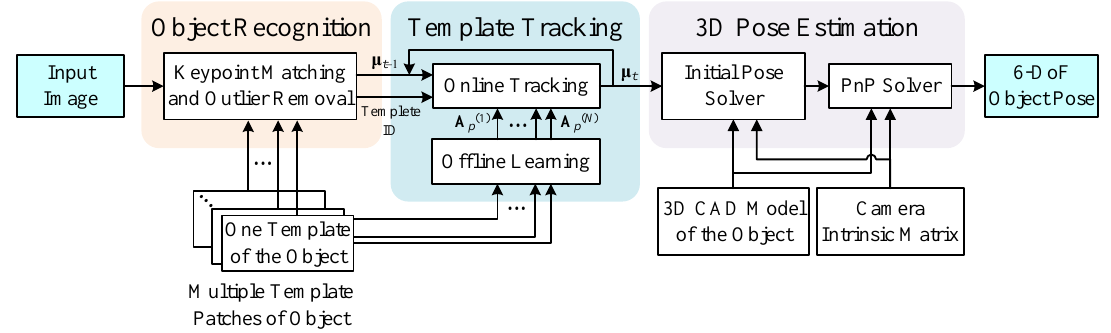
Figure 1. System framework of the proposed model-based object pose estimation algorithm.